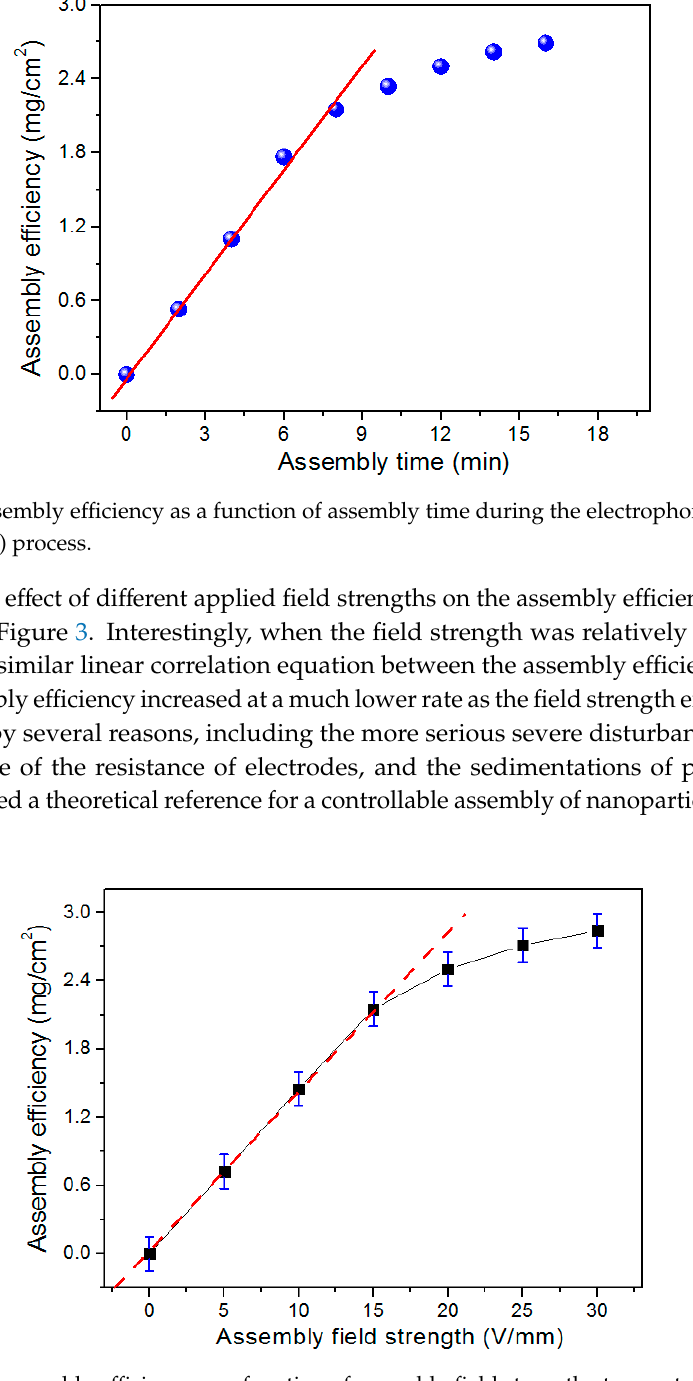
Figure 3. The assembly efficiency as a function of assembly field strength at room temperature.